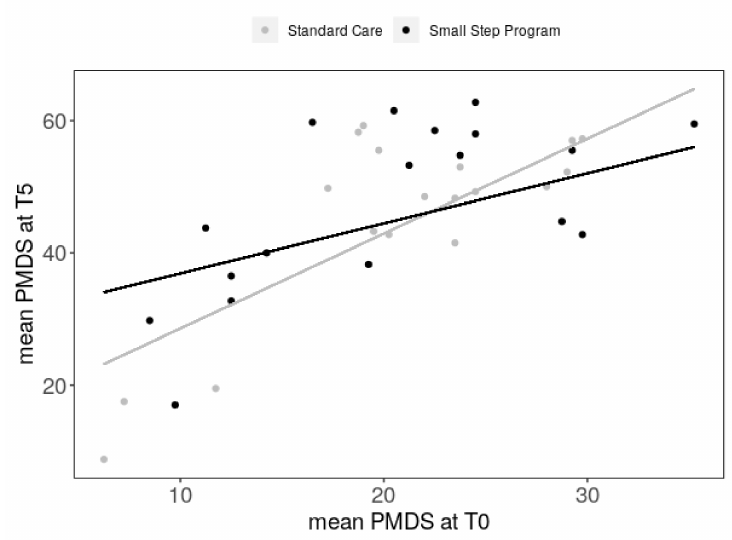
Figure 2. A general linear model showing that the group e ff ect on mPDMS-2 after intervention (T5) depended on the baseline (T0) values (interaction, p = 0.02). Data are represented in black for Small Step and grey for Standard